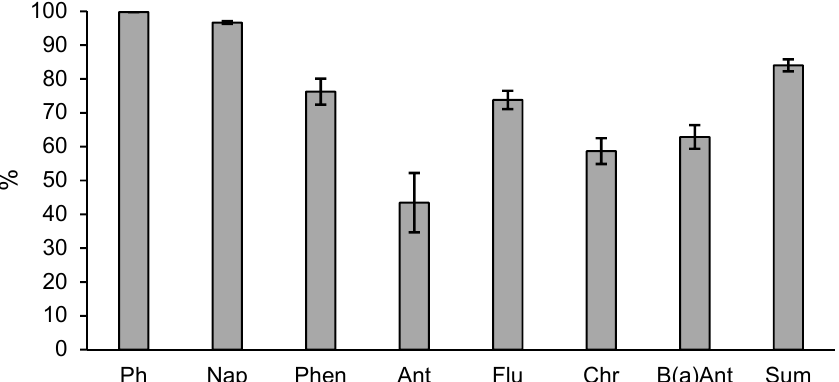
Figure 5. Mean percentage decrease of phenols and PAHs in the soil after enhanced natural attenuation; data are expressed as mean ± standard error; Ph—phenols, Nap—naphthalene, Phen— phenanthrene, Ant—anthracene, Flu—fluoranthene, Chr—chrysene, B(a)Ant—benzo(a)anthra-